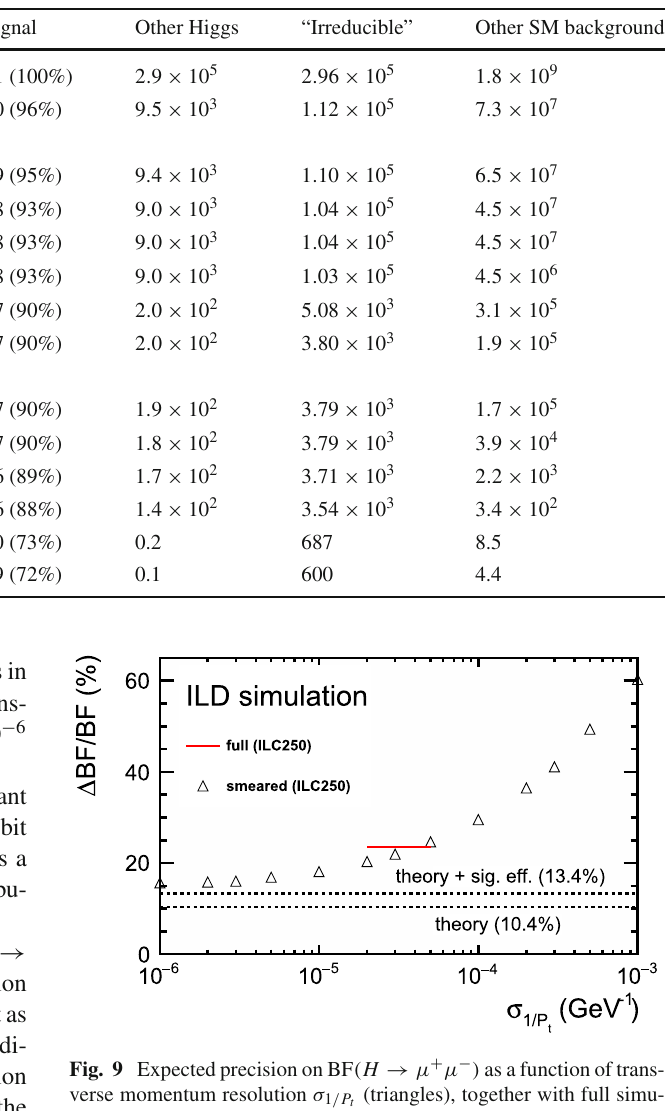
becomes so narrow that the background contribution under- neath the peak doesn’t have a significant effect